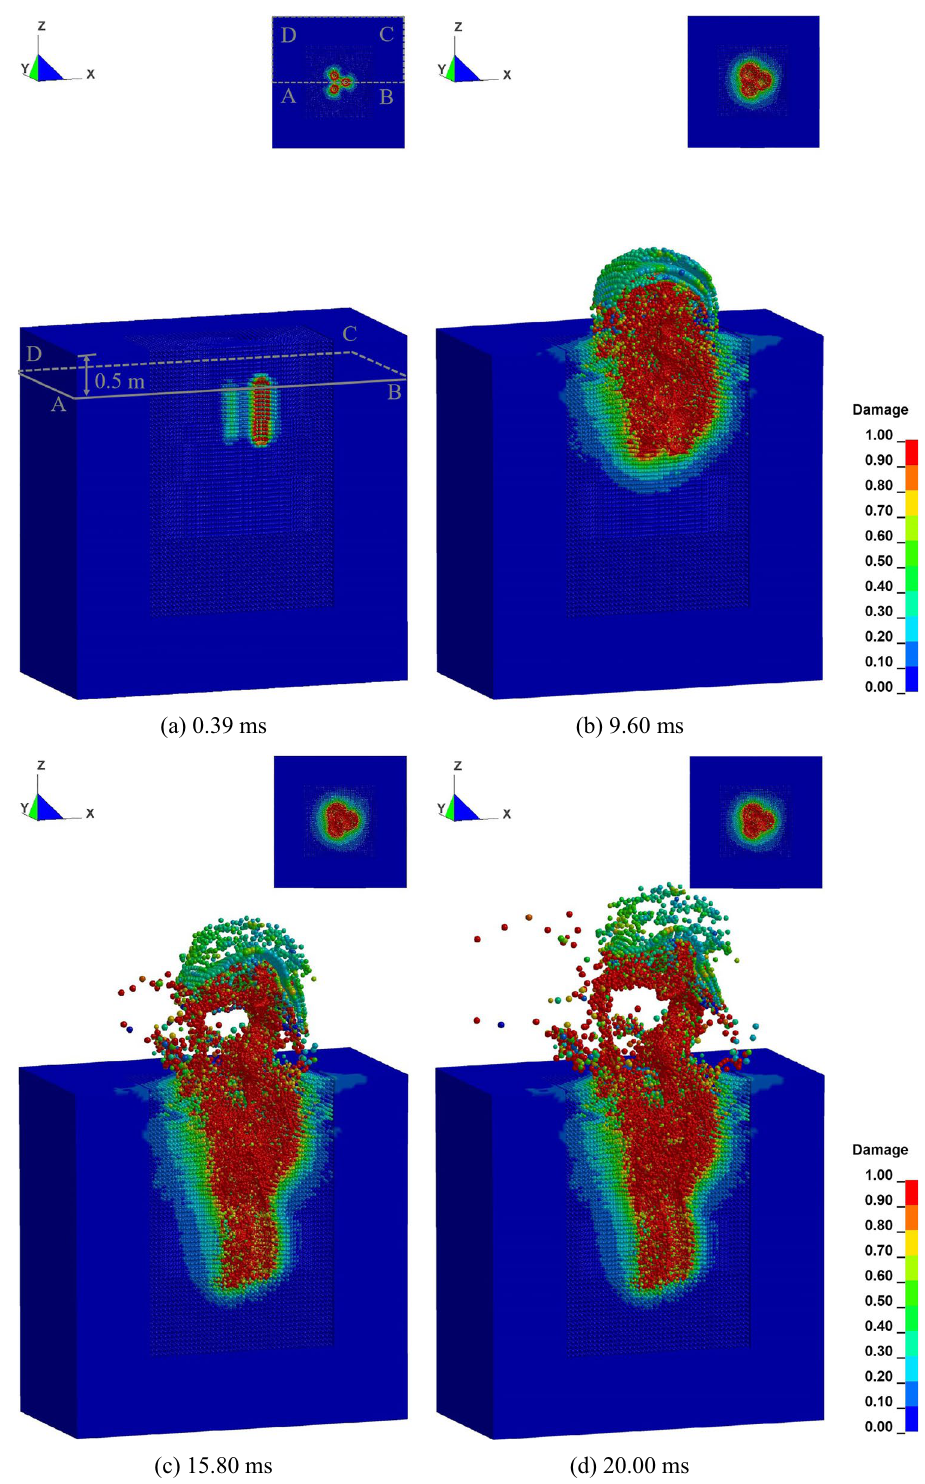
Fig. 10 Deep hole dispersed charge cut blasting process. a 0.39 ms; b 9.60 ms; c 15.80 ms; d 20.00